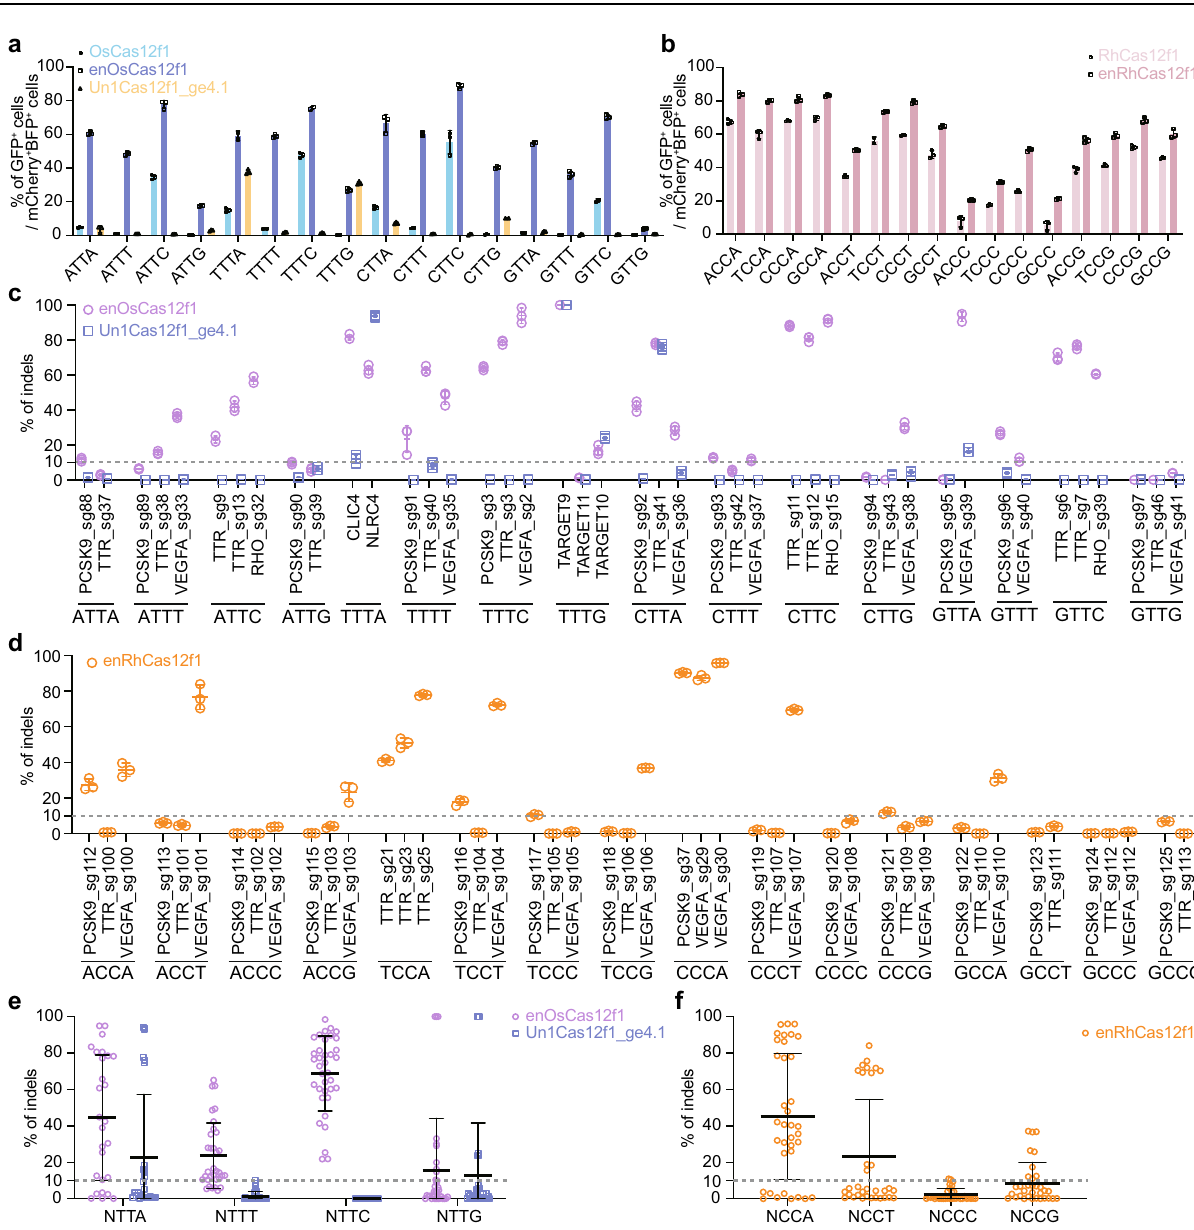
enRhCas12f1 and Un1Cas12f1_ge4.1 at endogenous loci. Values and error bars represent mean and s.d. ( n =3). e , f Summary of indel ef fi ciencies of enOsCas12f1, Un1Cas12f1_ge4.1, and enRhCas12f1. Values and error bars represent mean and s.d. from biologically independent experiments. Source data are provided as a Source Data fi